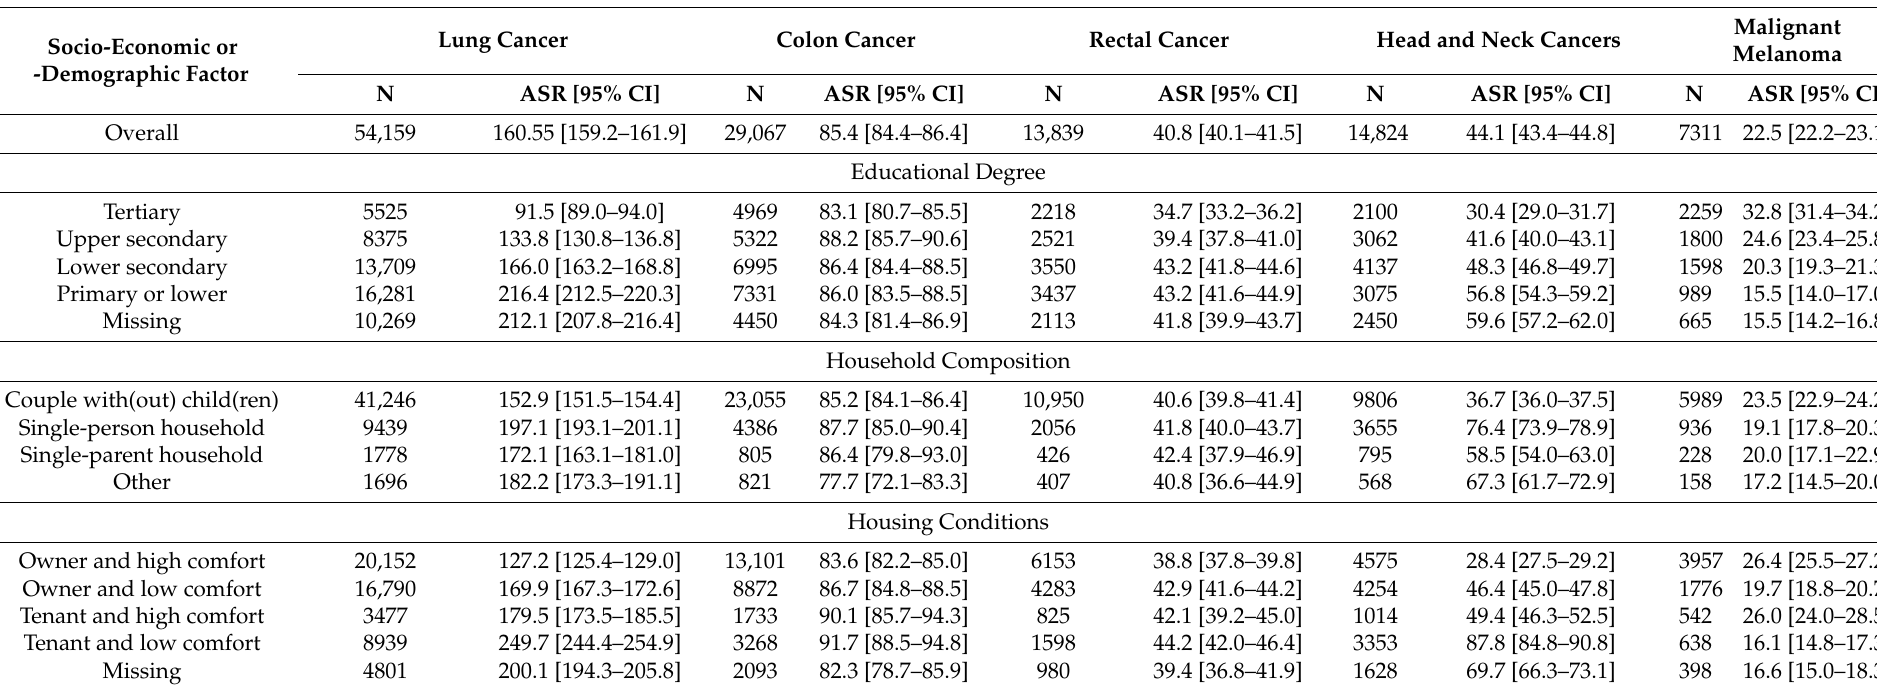
cancer type among men over